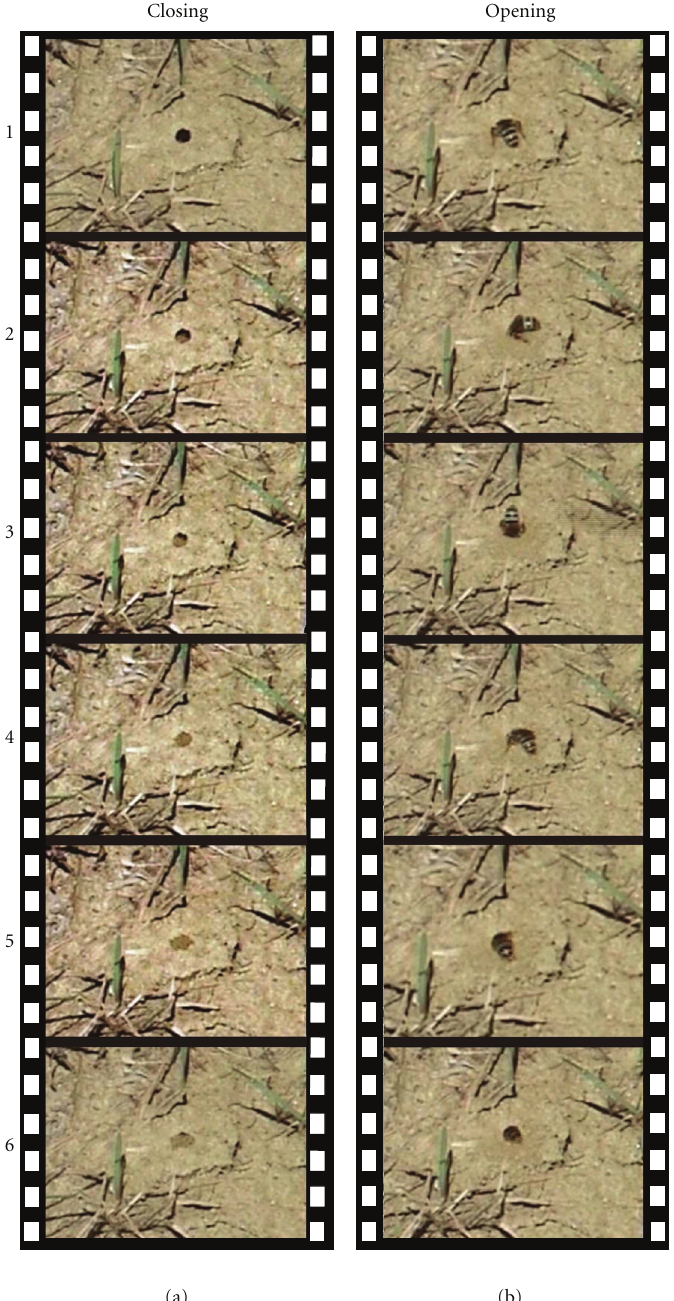
Figure 7: Nest closing and reopening. (a) Closing of an entrance hole from the inside of the nest by an egg-laying female; the sealing itself took 8 seconds while the whole closing activity continued over a further five minutes; images a 1 to a 6 were taken every seconds. (b) Opening of the nest entrance by circling movements by a worker bee from outside. This process took 8 minutes. The nest entrance was closed up at 11:20 h; at 11:28 h the worker bee in the image reopened the nest from outside. Four minutes later, the entrance hole was closed again. The images b 1 to b 6 were taken in the last minute before the forager bee succeeded to enter the nest.